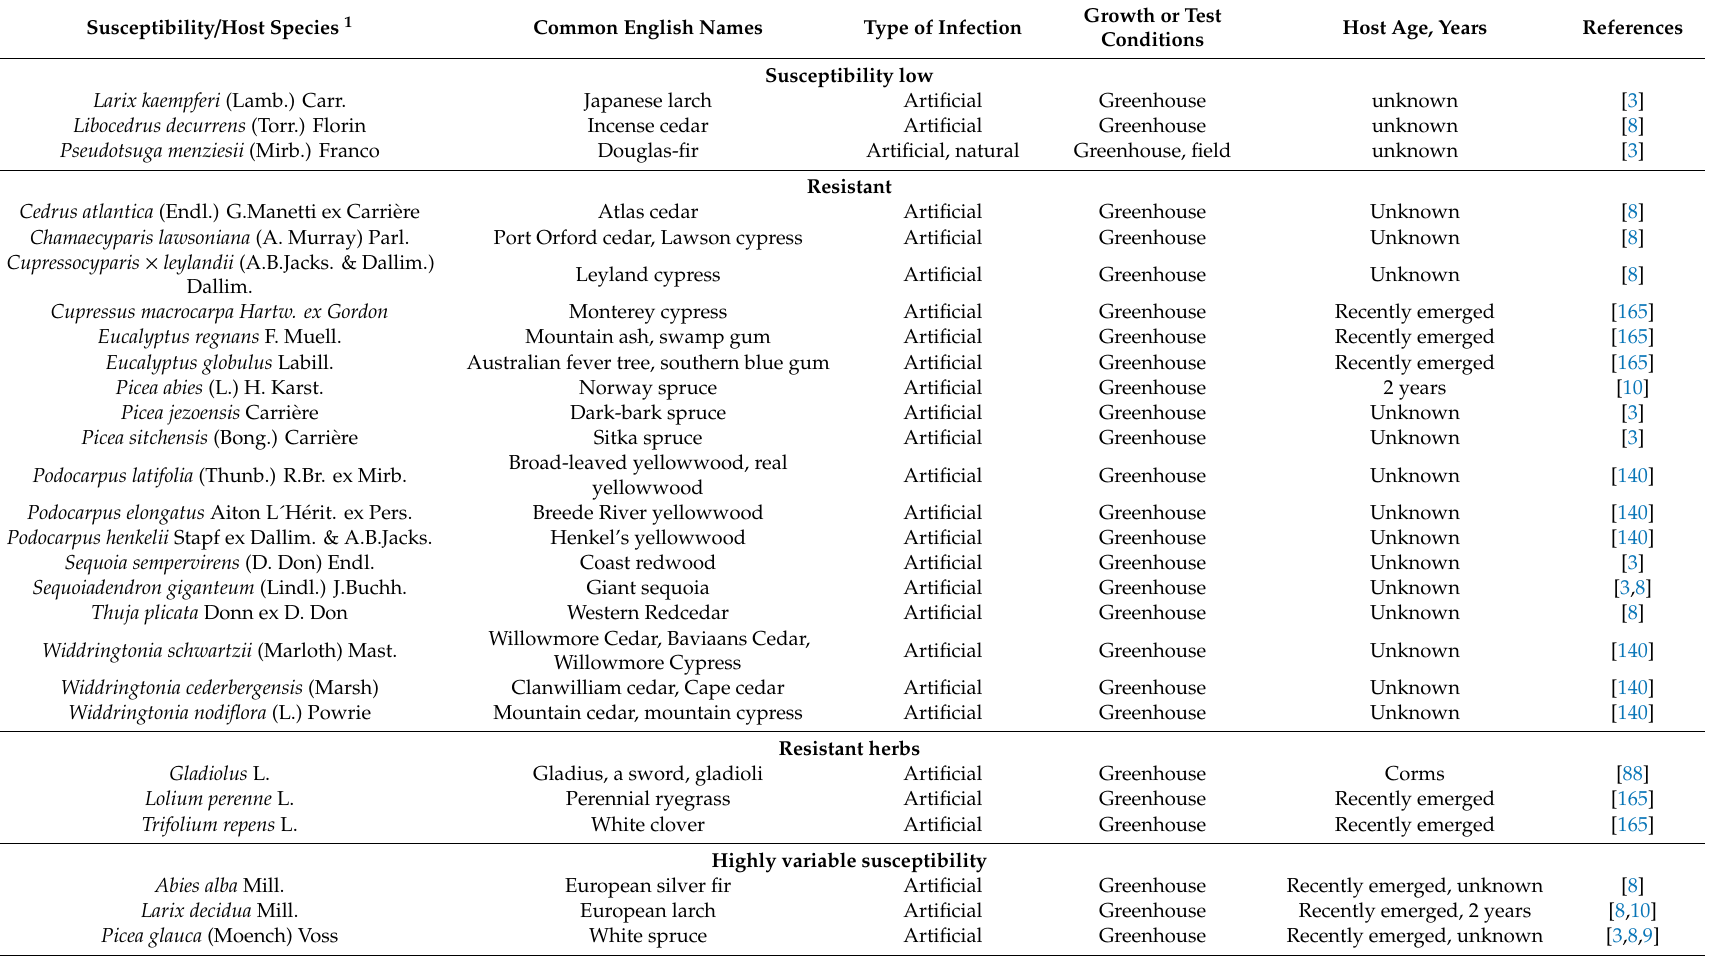
Table 6. Susceptibility list of non-pine species to Fusarium